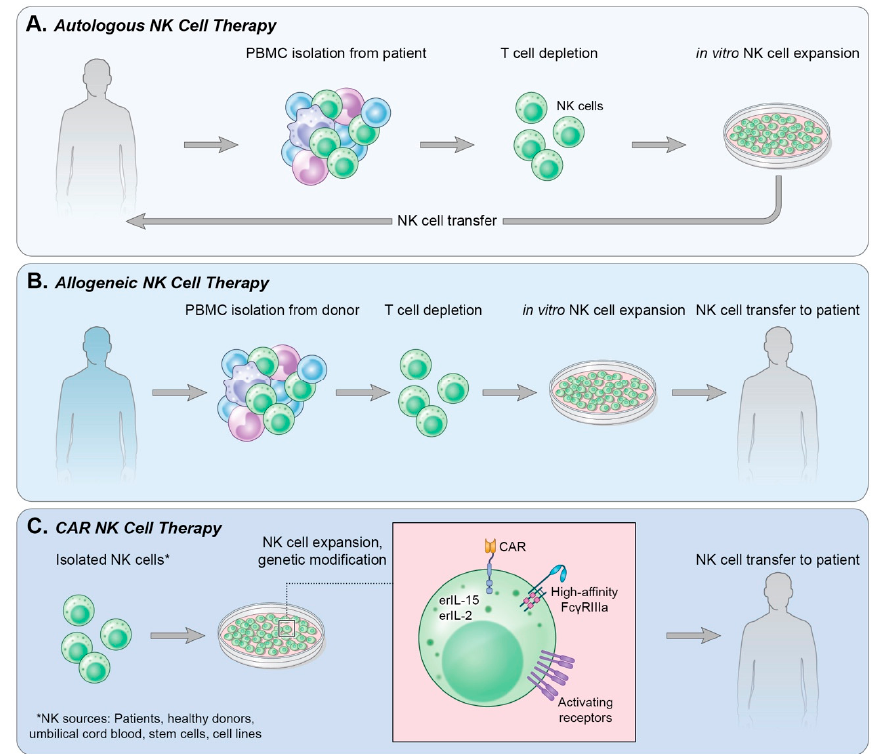
Figure 1. Methods of NK cell therapy. ( A ) Autologous NK cell therapy uses a patient’s own endogenous NK cells isolated from peripheral blood. T cells are depleted from the culture followed by in vitro expansion of NK cells and reinfusion into the patient. ( B ) Allogeneic NK cell therapy isolates NK cells from a healthy donor’s PBMCs in a process similar to that in ( A ); however, following NK cell expansion in vitro, the cells are infused into a patient. ( C ) CAR NK therapy can use NK cells derived from various sources. NK cells are then genetically modified to express receptors and cytokines of choice and expanded. The CAR NK cells are then infused into a